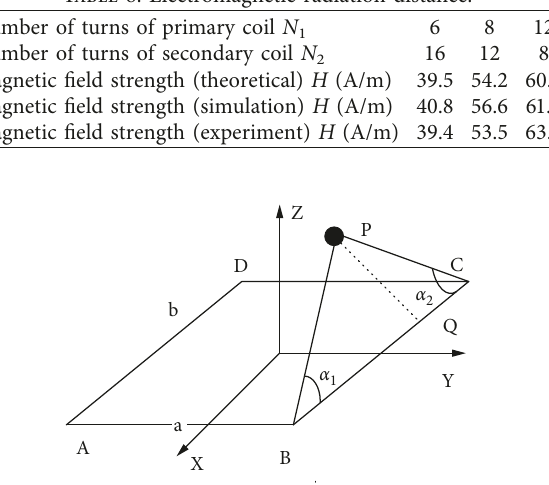
Figure 16: Rectangular coil magnetic field calculation